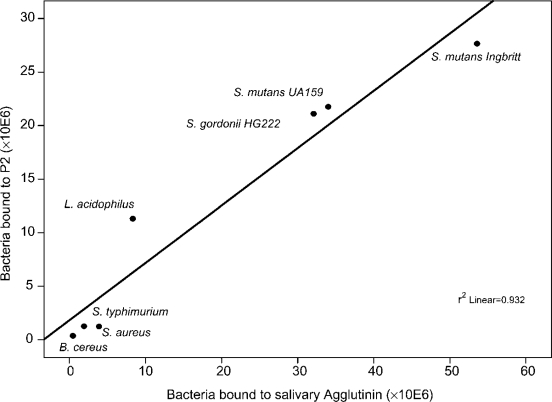
Correlation between bacteria binding to DMBT1SAG and SRCRP2 [67].